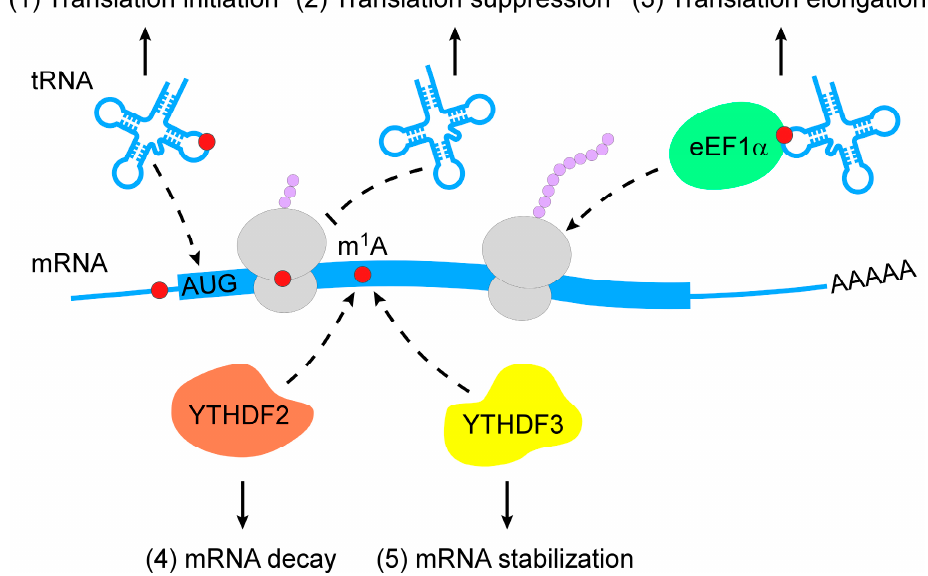
Figure 2. Action mechanisms of m 1 A in RNA metabolism. m 1 A RNA modification regulates RNA metabolism in multiple layers (from top to bottom: (1) m 1 A RNA modification stabilizes tRNAs to promote translation initiation; (2) m 1 A-modified mRNAs interfere with Watson–Crick base-pairing with tRNA to suppress translation; (3) m 1 A-modified tRNAs are coupled with eEF1 α to polysomes to promote translation elongation; (4) m 1 A-modified mRNAs are subjected to degradation by interacting with YTHDF2; (5) m 1 A-modified mRNAs become stable when they bind to YTHDF3). m 1 A, N 1 -methyladenosine; eEF1 α , eukaryotic elongation factor 1- α ; YTHDF, YTH domain-containing family protein.